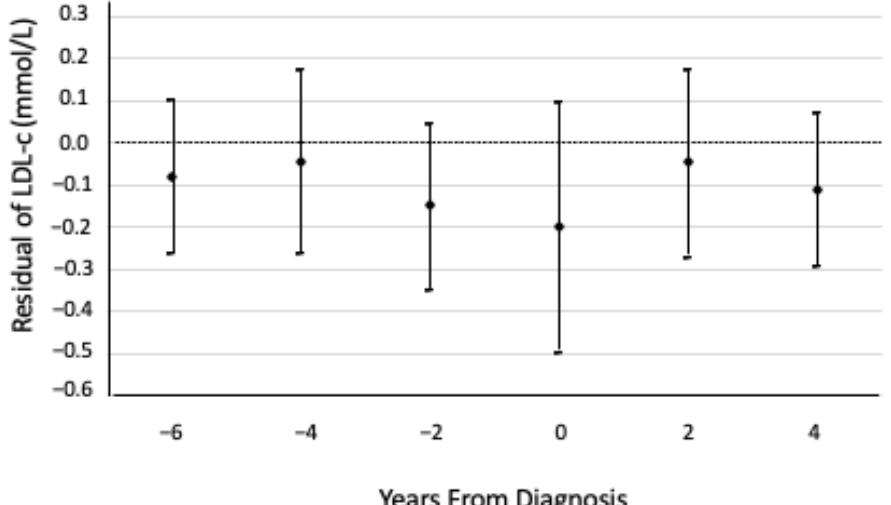
Figure 1. Means and 95% confidence intervals of low-density lipoprotein cholesterol (LDL-C) residuals relative to the expected LDL-C concentrations had those cases not developed rheumatoid arthritis (RA), over time, from the date of RA diagnosis. Residuals are based on a linear regression model — using only participants who did not develop RA — of LDL-C on years to end of follow-up, adjusted for age at baseline, sex, BMI, HDL-C, and TG, and accounting for repeated measures on each participant. The expected LDL-C concentrations from timepoints − 6 to 4 were 2.39, 2.50, 2.62, 2.72, 2.83, and 2.95 mmol/L, respectively.